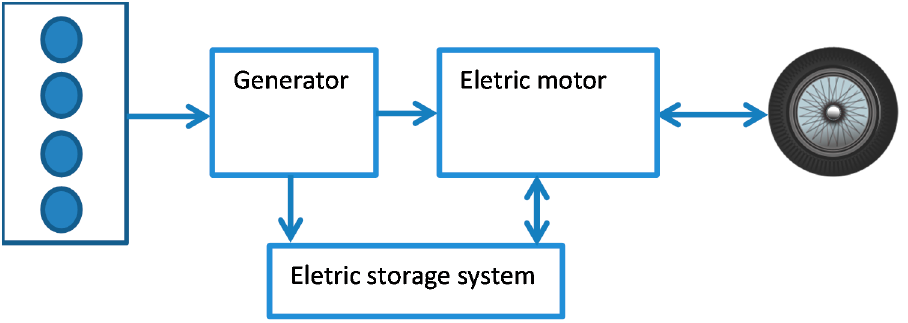
Table 3. Technical specifications of Scania Omnilink HEV-ED95 bus.